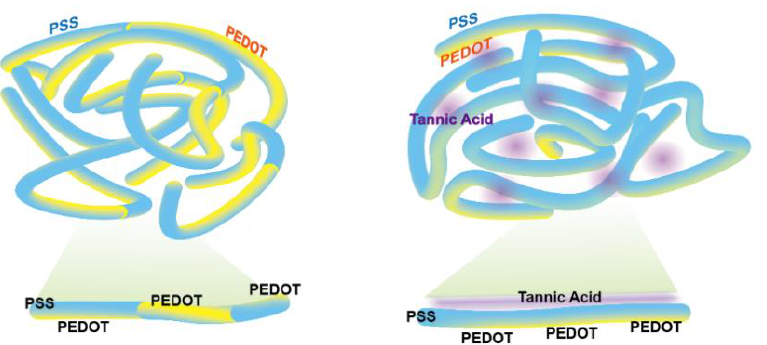
Figure 6. Schematics for chemical and film morphology of TA-treated PEDOT:PSS: ( left ) Structure of bare PEDOT:PSS, and ( right ) changes of PEDOT:PSS via treatment of the TA.